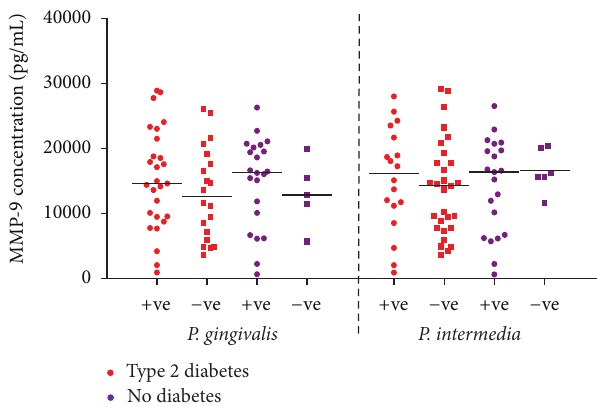
Figure 4: Distribution of salivary MMP-9 concentrations (pg/mL) according to the prevalence of P. gingivalis and P. intermedia in subjects with and without type 2 diabetes regardless of the periodontal status ( 𝑛 = 80 ).